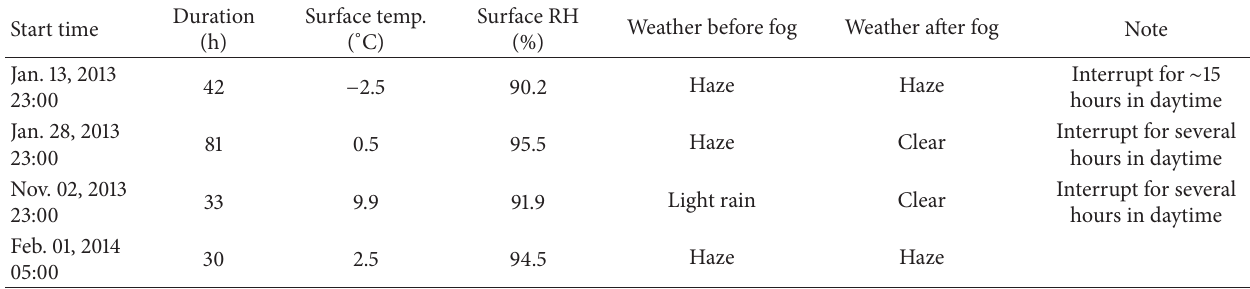
Table 1: Start time, duration, average surface air temperature, relative humidity, and weather conditions before and after fog for the four fog events occurring in Ji’nan during the period from March 2012 to February 2014.